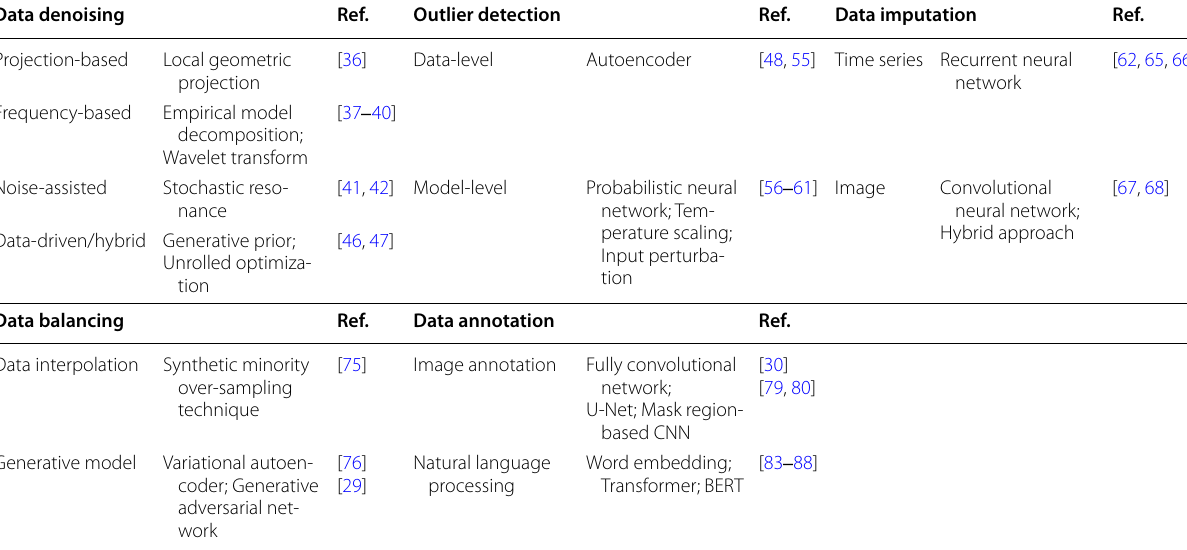
Table 1 Representative techniques for data curation Data denoising Ref. Outlier